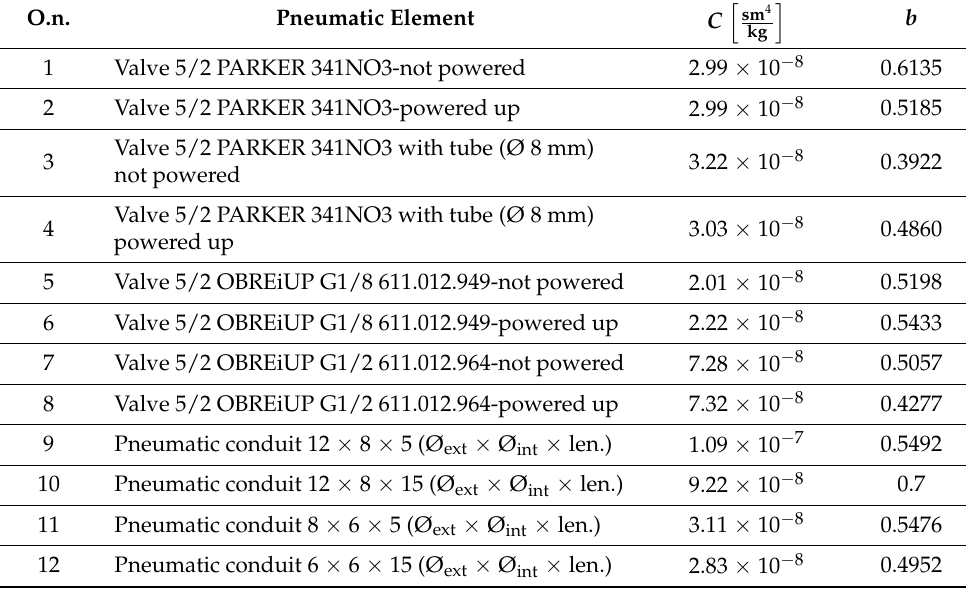
Table 3. List of catalog parameters of pneumatic elements. O.n.